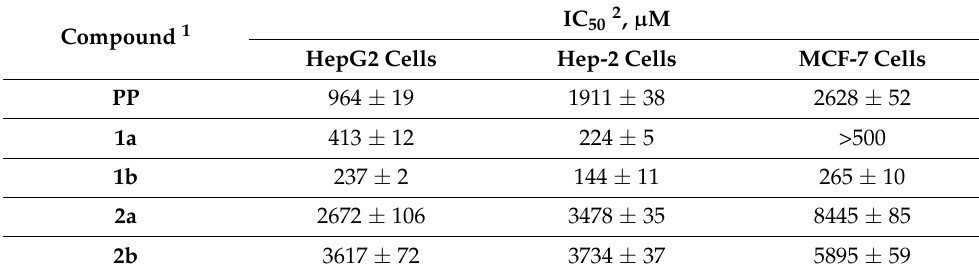
Table 2. The cytostaticity (IC 50 ) of compounds against HepG2, Hep-2 and MCF-7 cells. The values are the mean of three wells ± standard deviation (SD).